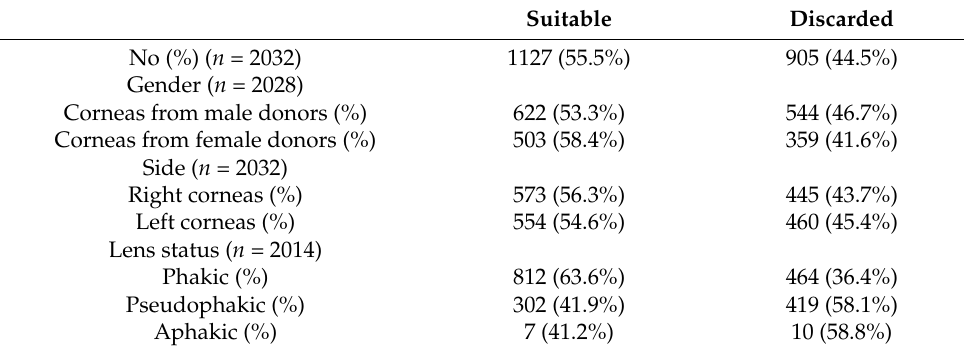
Table 6. ECD in relation to life